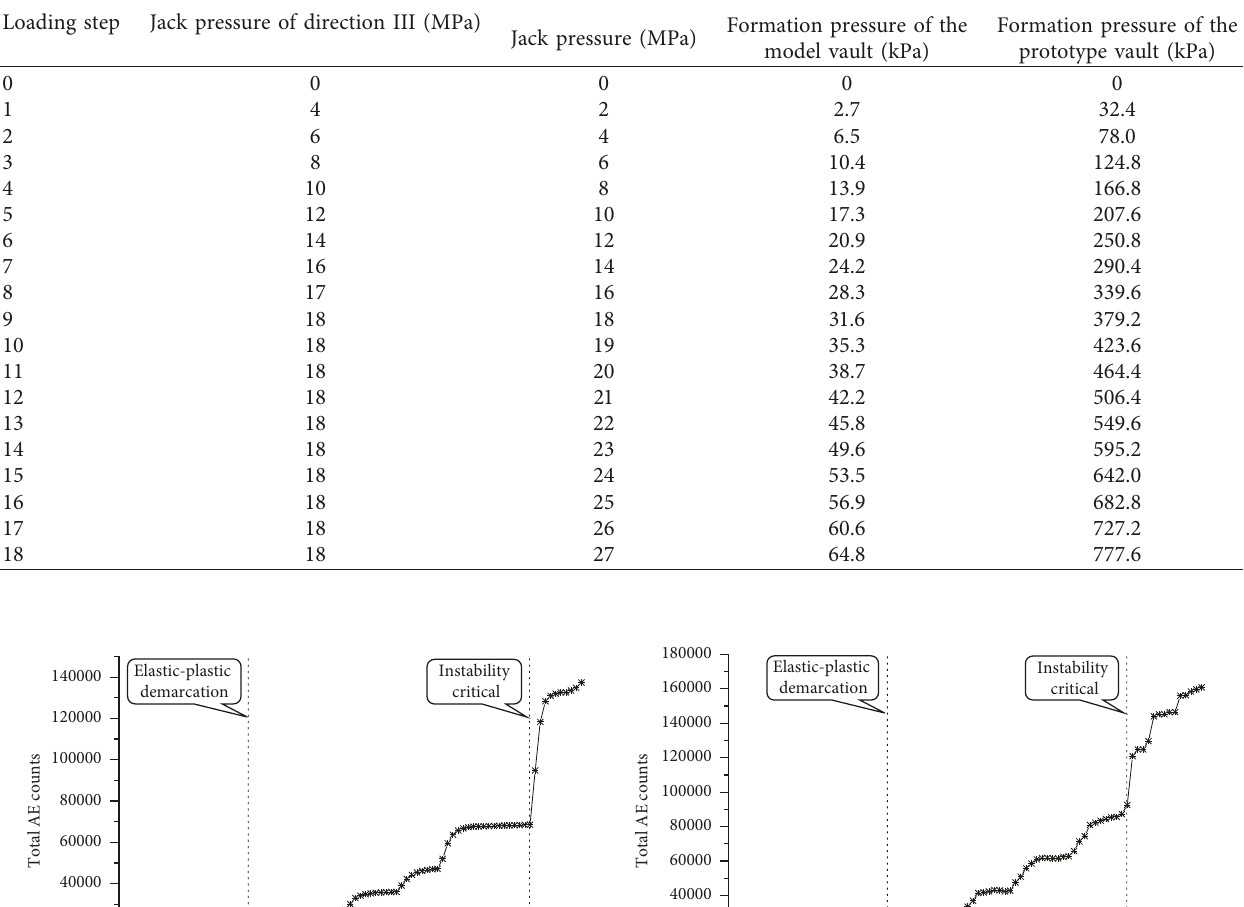
Table 7: Test load applying scheme.